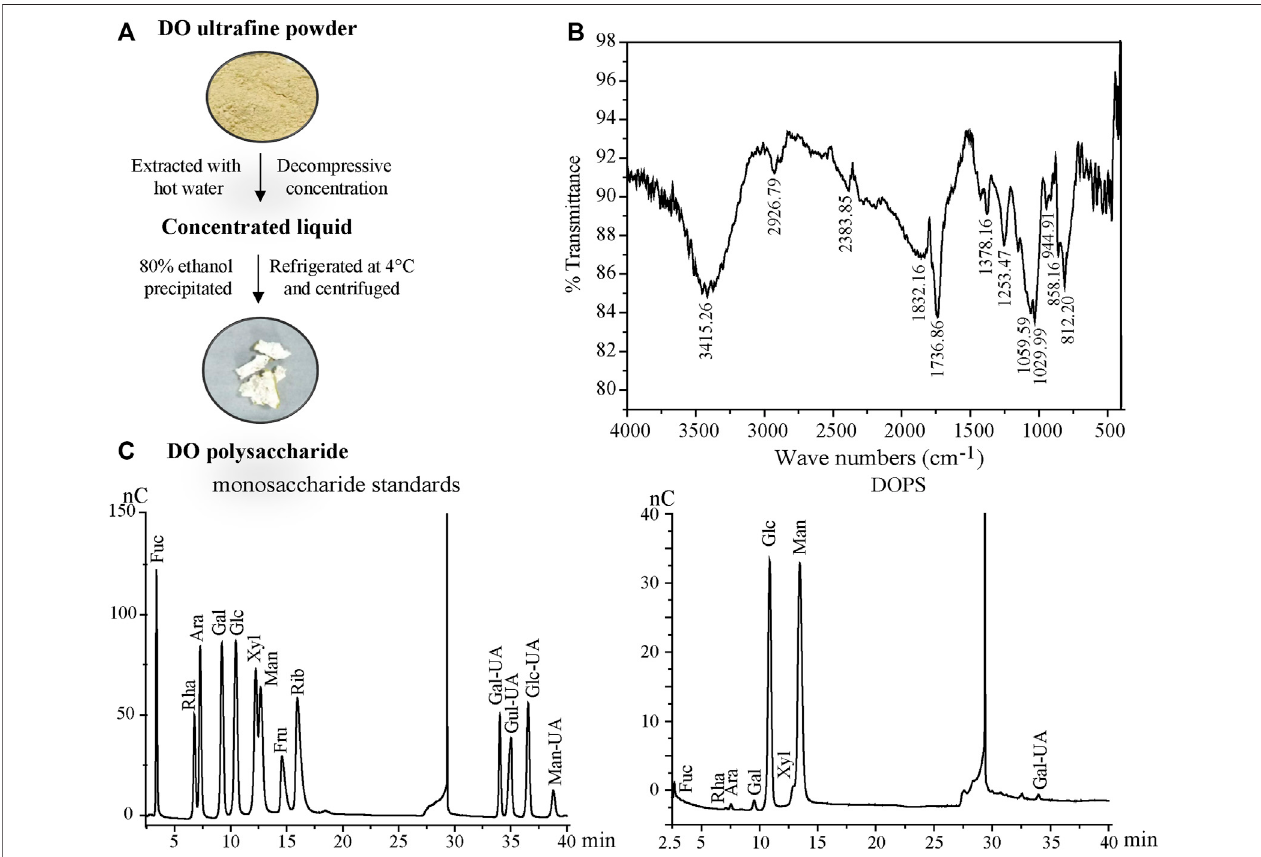
FIGURE 1| Preparation and properties ofDOPS. (A) Preparation fl ow diagram of DOPS. (B) Analysis ofDOPS byFourier transform infrared spectroscopy (FT-IR). (C) High-performanceliquidchromatography(HPLC)analysesofmonosaccharidestandardsandDOPS.DO: Dendrobiumof fi cinale ;Fuc:Fucose;Rha:Rhamnose;Ara: Arabinose; Gal: Galactose; Glc: Glucose; Xyl: Xylose; Man: Mannose; Fru: Fructose; Rib: Ribose; Gal-UA: Galacturonic acid; Gul-UA: Glucuronic acid; Glc-UA: Mannuronic acid; Man-UA: Guluronic